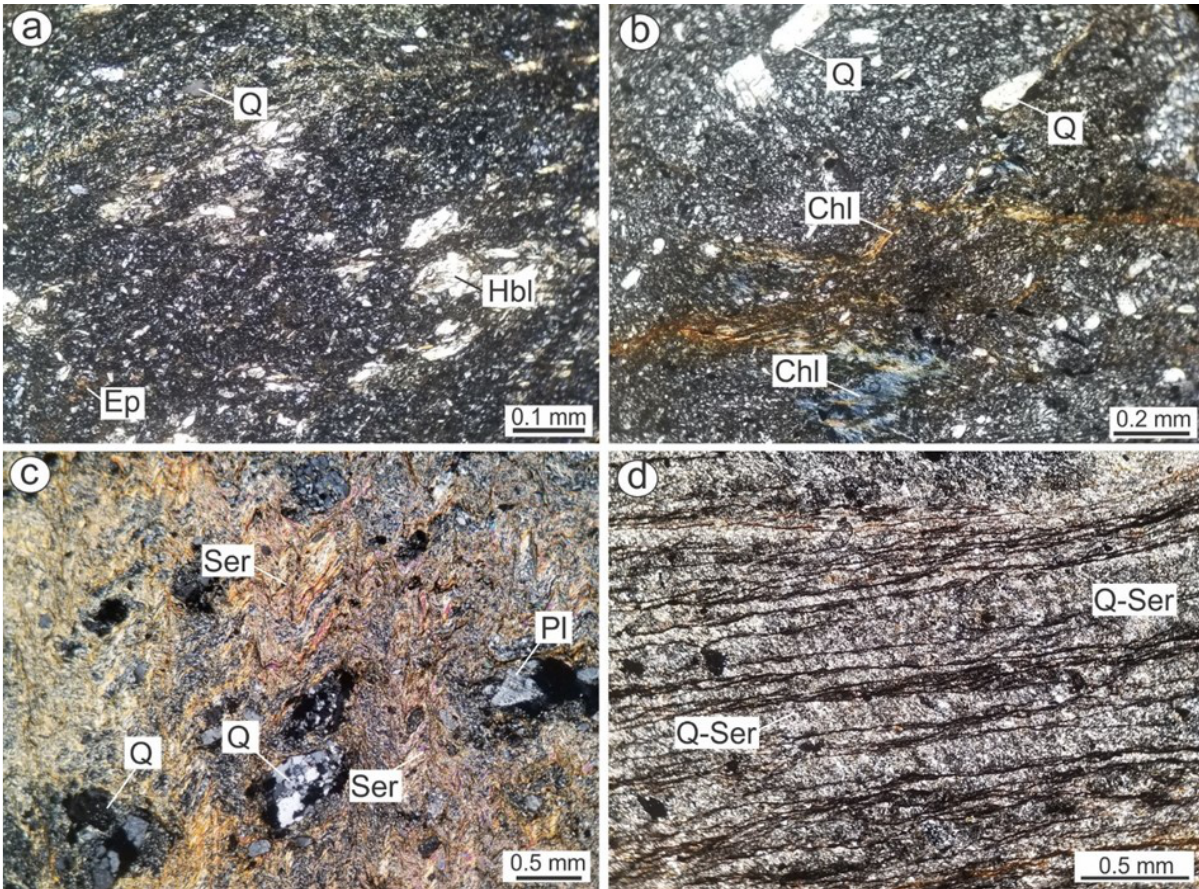
Fig. 3. Representative microphotographs of metamorphic rocks from the Mogoitiin Gol area. a) Hornblende schist (sample AO1), b) Chlorite-quartz schist (sample 324/1), c) Quartz-sericite schist (sample 323), d) Black schists (sample 320). Abbreviations: Q – quartz, Pl – plagioclase, Hbl – hornblende, Ep – epidote, Chl – chlorite, Ser – sericite. All photomicrographs are under cross-polarized